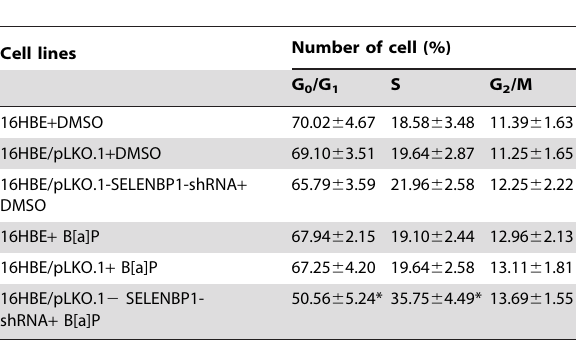
Table 3. Cell cycle distribution of 16HBE with knockdown of SELENBP1 and controls after repeated treatment with 1 m m B[a]P or DMSO for 18